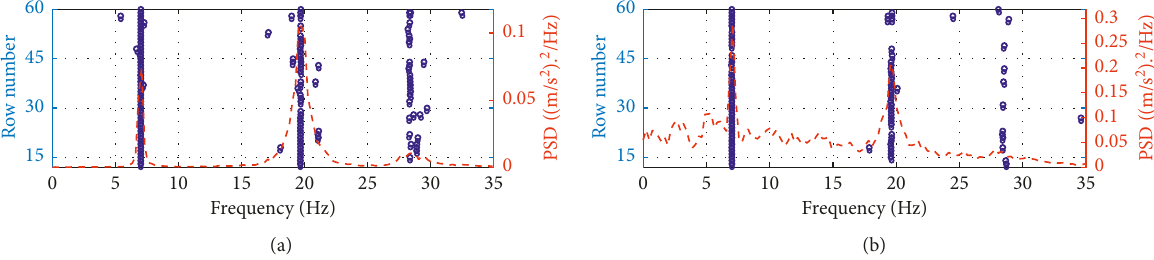
Figure 5: Stabilization diagram of ACS-SSI. (a) SD of ACS-SSI (SNR